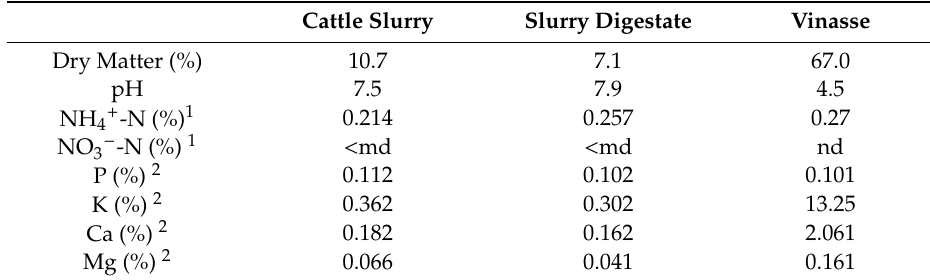
Table 3. Dry Matter, pH KCl , and nutrient content of the three